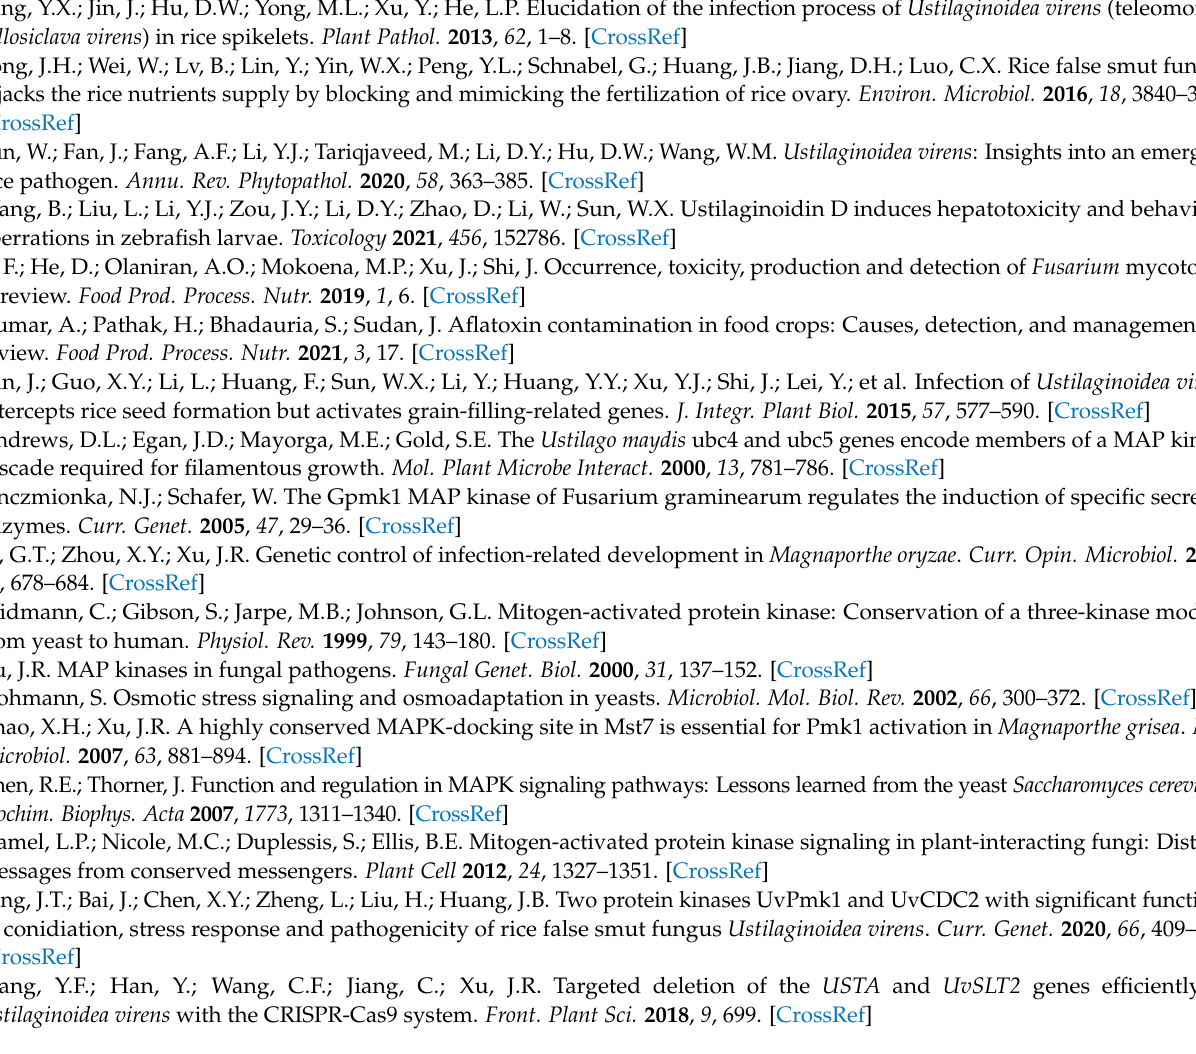
Table S3: GO analysis of differentially expressed genes between Jt209 and ∆ Uvste50